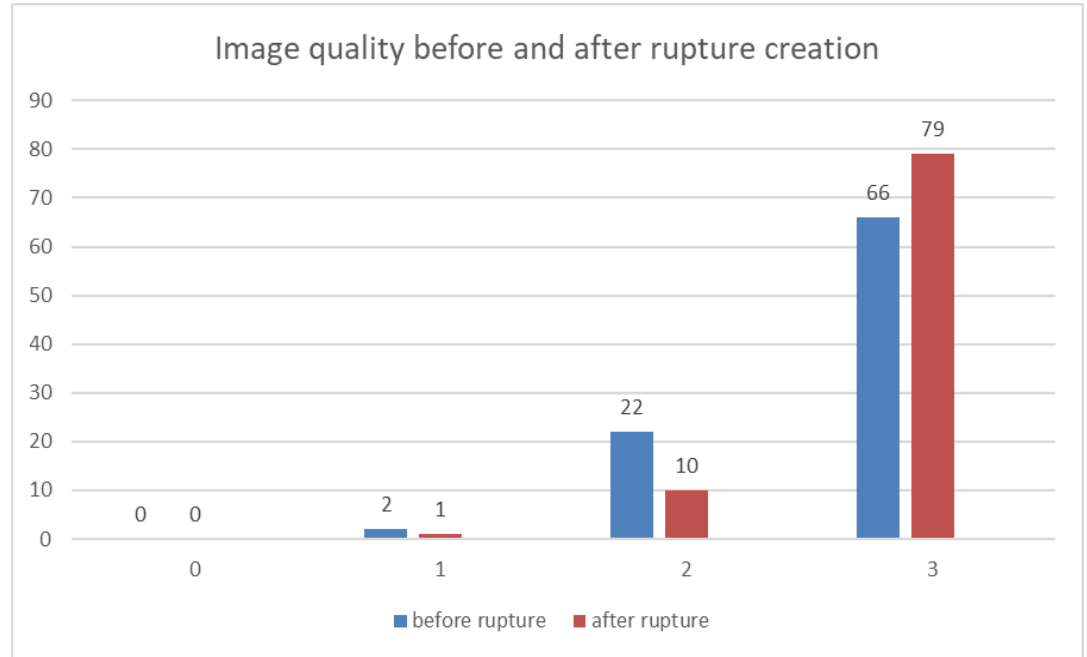
Figure 2. Image quality for the visualization of finger flexor pulleys before and after rupture creation evaluated according to a 4-point Likert-type scale from not evaluable (0) to excellent (3), separated by the two reviewers in consensus. No specimen was rated as having a not-evaluable image quality (0).